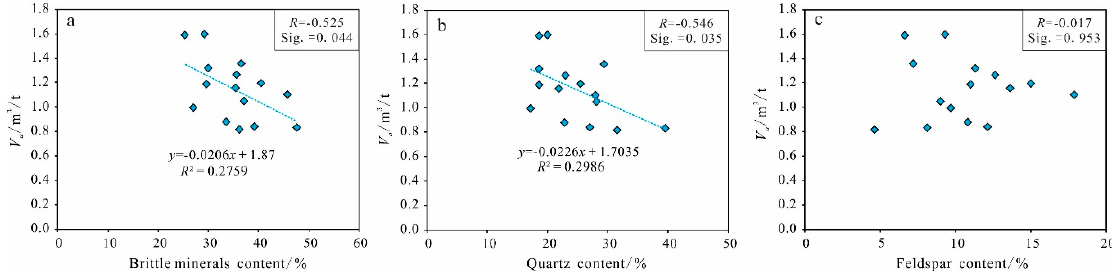
Figure 13. Influence of brittle minerals on AGC in shales. ( a ) Negative relationship between V a and the total brittle mineral content. ( b ) Negative relationship between V a and the quartz content. ( c ) No obvious relationship between V a and the feldspar content.